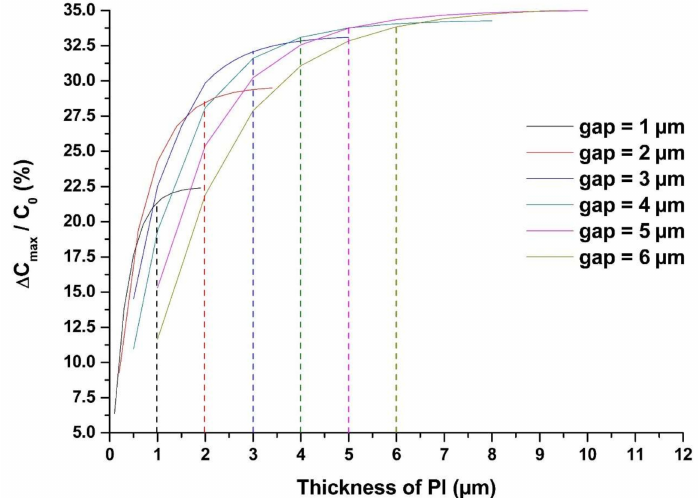
Figure 3. Influence of sensing film’s thickness on sensor sensitivity. The vertical ordinate of the intersection of all the dashed lines and the solid curves represents the sensor’s ∆ C max /C 0 when the sensing film thickness is equal to the gap between the